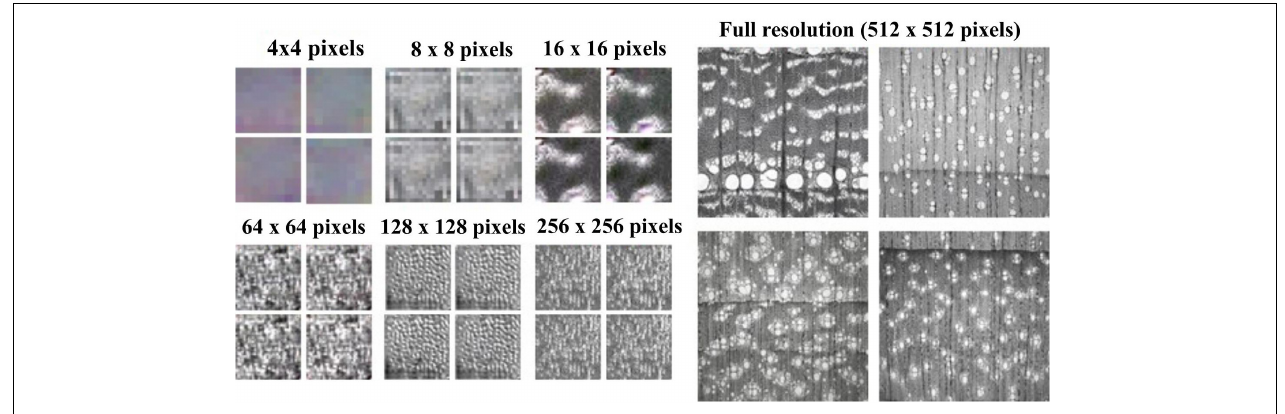
FIGURE 2 | Overview of StyleGAN training using progressively increased image resolution from 4 × 4 pixels to 512 × 512 pixels.